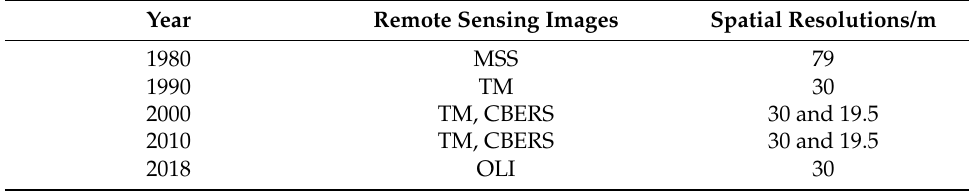
Table 1. Remote sensing images used in the